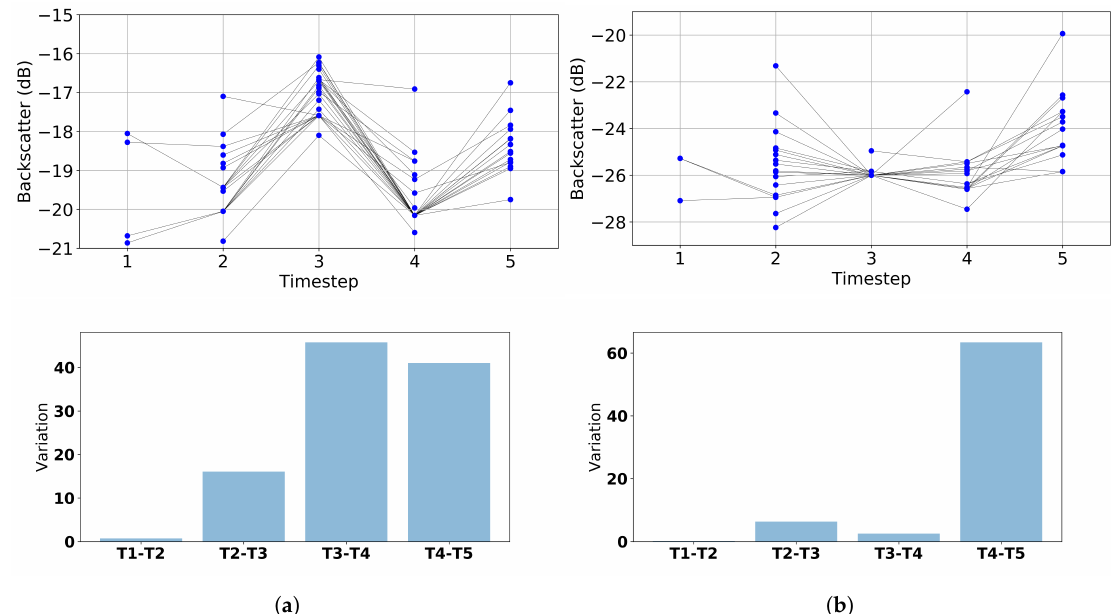
Figure 17. Temporal profile and variation VV versus VH polarisation for ascending SITS in the dynamic zone. ( a ) Ascending VV. ( b ) Ascending